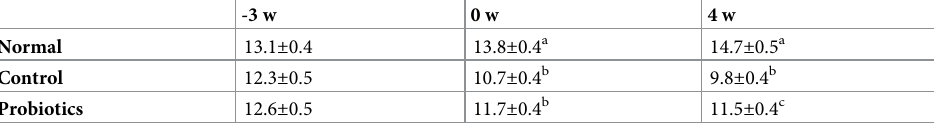
The normal group (N = 20) was untreated. The control group (N = 20) and the probiotics group (N = 20) received adenine orally from Week -3 to Week 0 to induce CKD. The control group received PBS orally from Week 0 to Week 4. The probiotics group received probiotics dissolved in PBS orally from Week 0 to Week 4. When the Bartlett test did not detect any significant deviation, a one-way analysis of variance was performed to determine whether there were any differences in the means of the three groups. Then, the significance of the intergroup mean differences was examined using Bonferroni’s test. A non-parametric comparison using the Kruskal–Wallis H test was performed if a deviation from variance homogeneity was significant. The level of significance was set at p < 0.05. Data are presented as means ± standard errors. a, b, c Different letters within columns indicate differences between the treatment groups ( p < 0.05). CKD, chronic kidney disease; PBS, phosphate-buffered